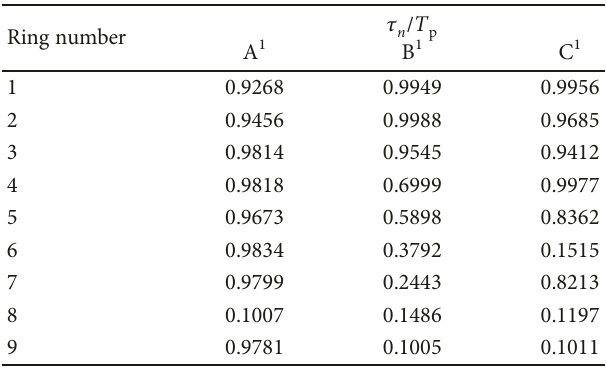
Table 3: The normalized switch-on time sequences for individuals A 1 , B 1 , and C 1 .